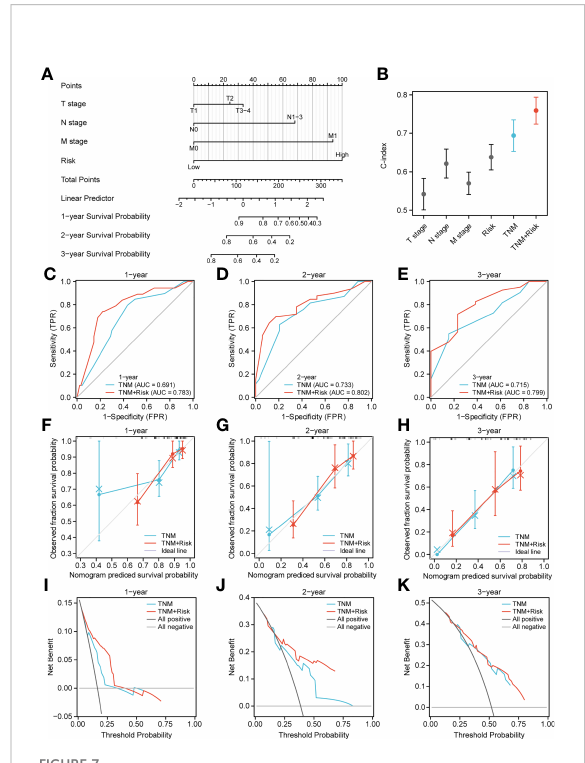
FIGURE 7 Nomogram analysis. (A) Nomogram composed of stage, T, N, M, and risk score for the prediction of 1-, 2-, and 3-years OS probability. (B) C-index analyses of T stage, N stage, M stage, risk score, TNM, TNM +risk score. (C – E) ROC curve for the nomogram based on TNM prognosis model and TNM +risk score model 1-, 3-, and 5-y survival. (F – H) Calibration plot of the TNM prognosis model and TNM +risk score model for 1-year (F) , 2-year (G) , and 3-year (H) OS. (I – K) DCA curve of TNM prognosis model and TNM +risk score for 1, 2, and 3